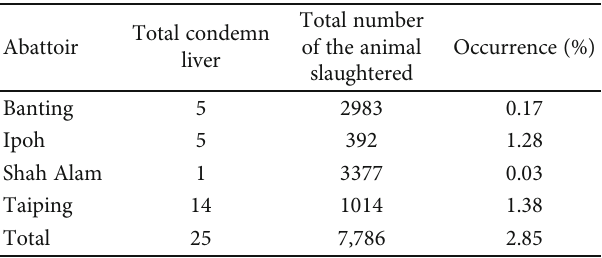
Table 1: The occurrence of fascioliasis in four slaughterhouses for one